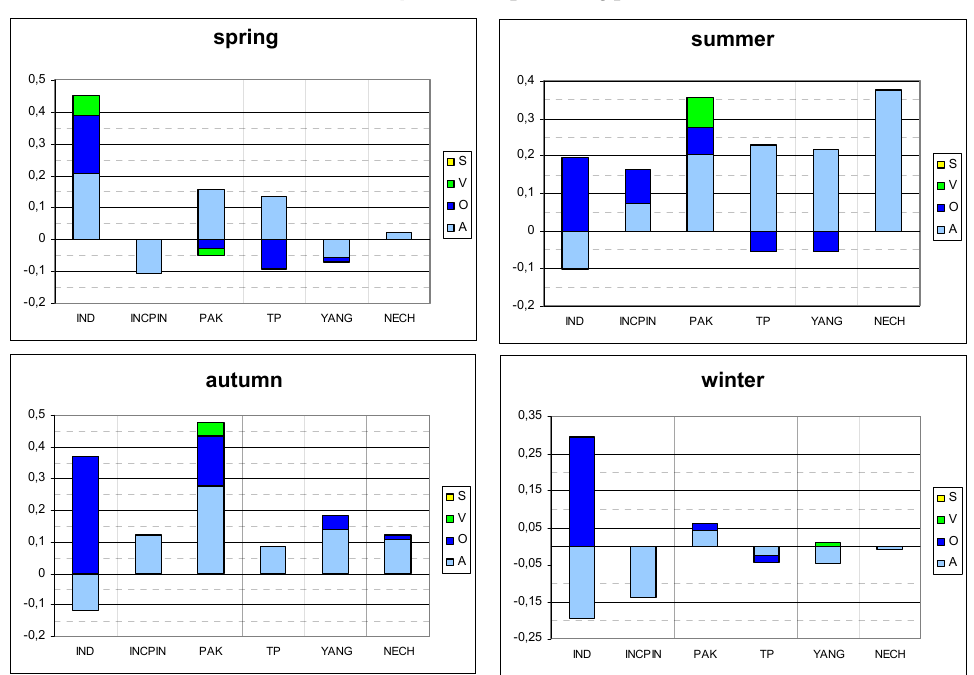
Fig. 6. Same as Fig. 5, but for evaporation anomalies [mm/day]. Please note the different scales.